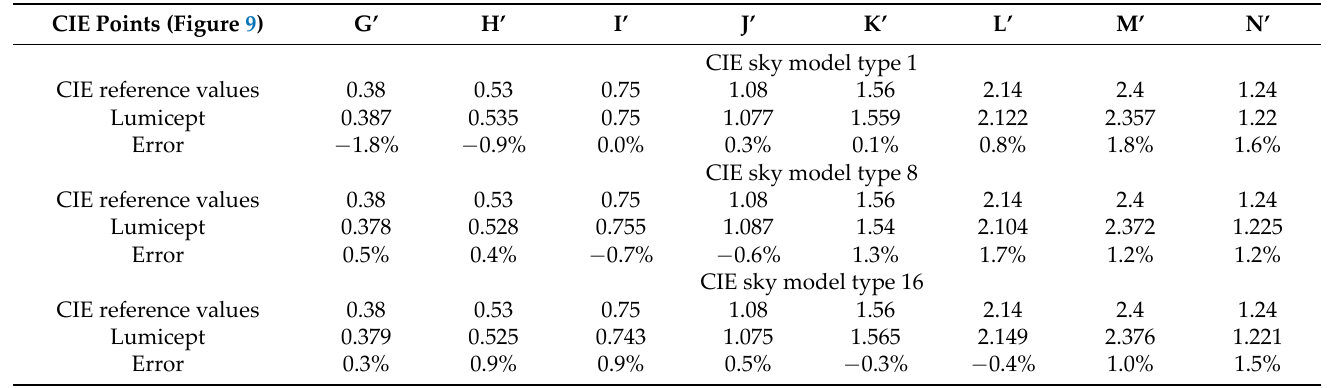
Table 10. Results of test 5.11 from CIE 171:2006. Points G’‑N’ on the ceiling (Figure